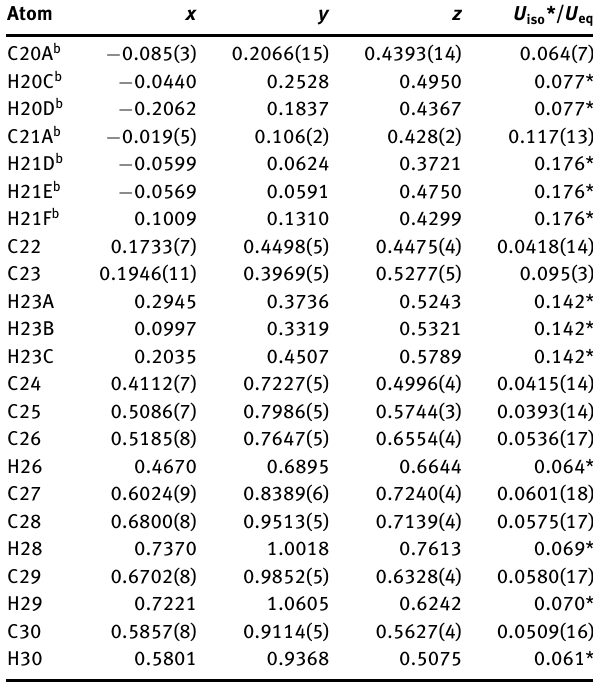
Table 2: Fractional atomic coordinates and isotropic or equivalent isotropic displacement parameters (Å 2